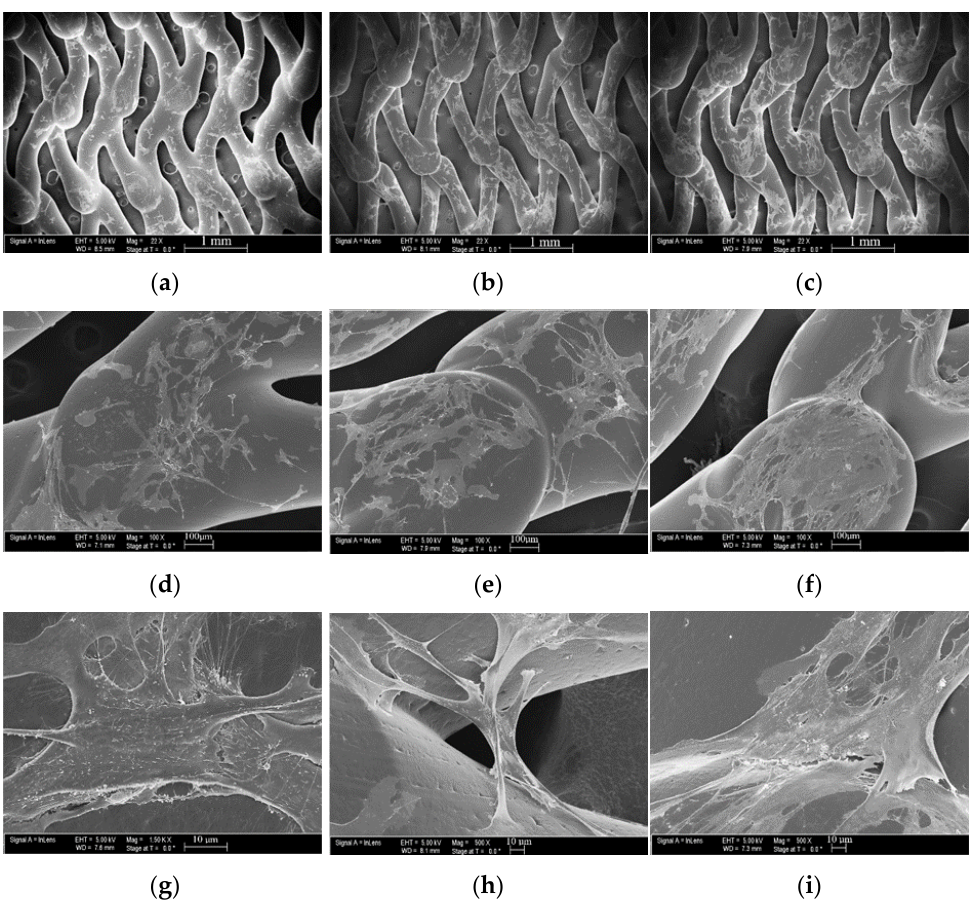
Figure 10. Cell morphology SEM imaging results for HUVECs seeded on PCL FDS samples incubated for 24-( a , d , g ), 36-( b , e , h ), and 48-h ( c , f , i ) with 1 mm ( a – c ), 100 µm ( d – f ), and 10 µm ( g – i ) scale bars.